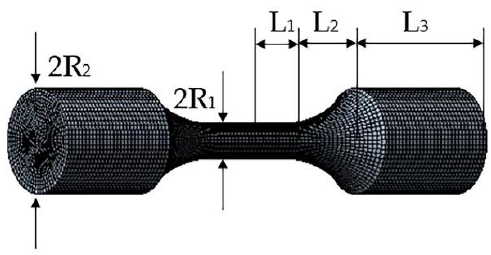
Figure 4. Simulation model of the dog-bone-shaped sample.